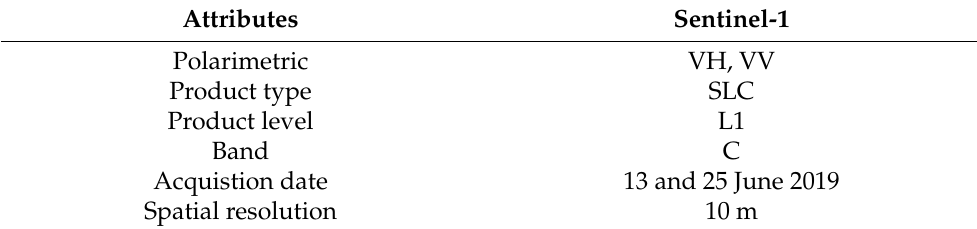
Table 1. Detailed information of the data used in this